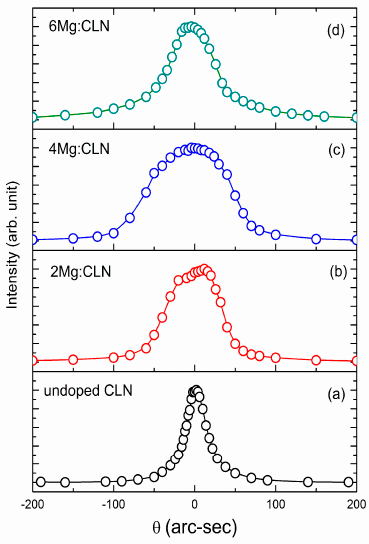
Figure 5. High resolution X-ray diffraction (HRXRD) curves of ( a ) undoped; ( b ) 2.0; ( c ) 4.0; and ( d ) 6.0 mol % Mg-doped CLN crystals.